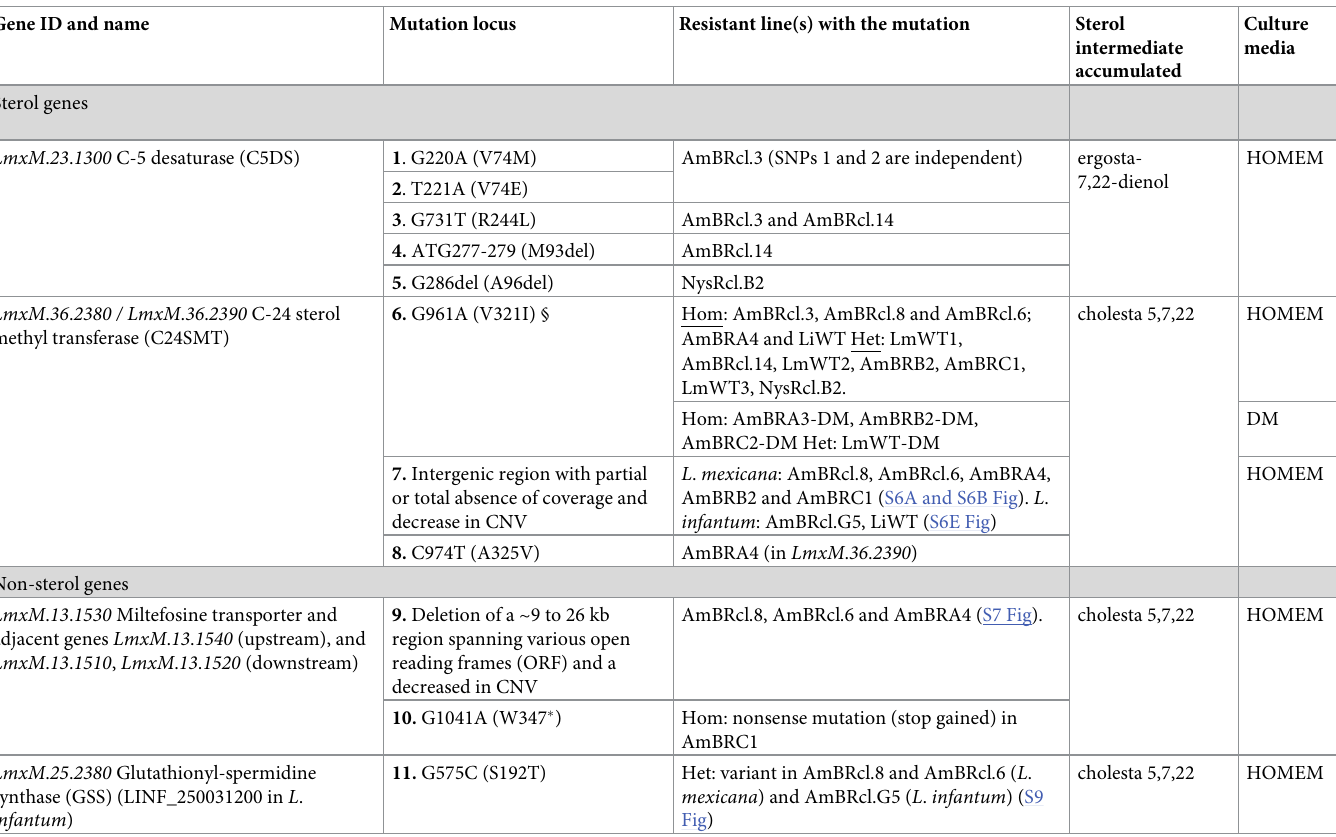
Table 1. WGS in sterol and non-sterol genes in polyene resistant lines of Leishmania spp. Gene IDs were retrieved from TriTrypDB in L . mexicana . Genotype and amino acid changes from variants in sterol genes is provided in S6 Table. A complete list of variants is provided for SNPs (S9 Table) and CNVs (S8 Table). Hom: homozy- gous; Het: Heterozygous. § This mutation is a pre-existing difference between both copies of the C24SMT gene and is associated with structural changes but not with drug